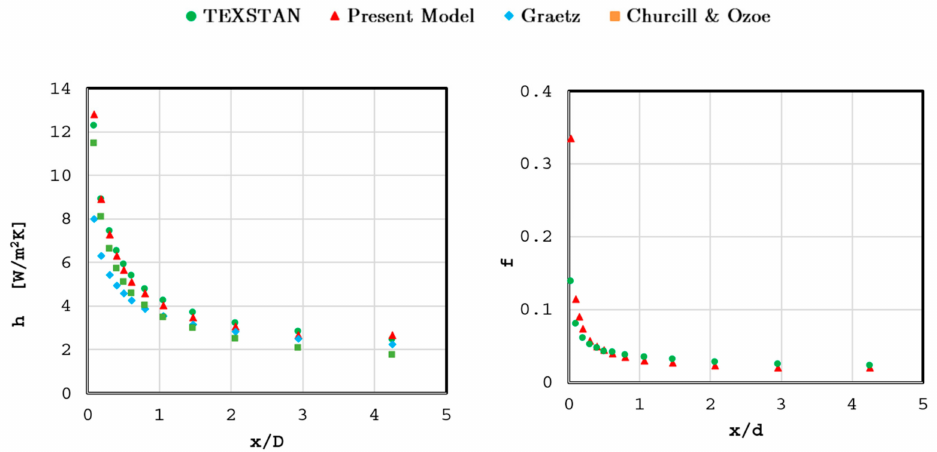
Figure 3. Results of the conjugate transfer model validation: heat-transfer coe ffi cient ( right ) and friction coe ffi cient ( left ).